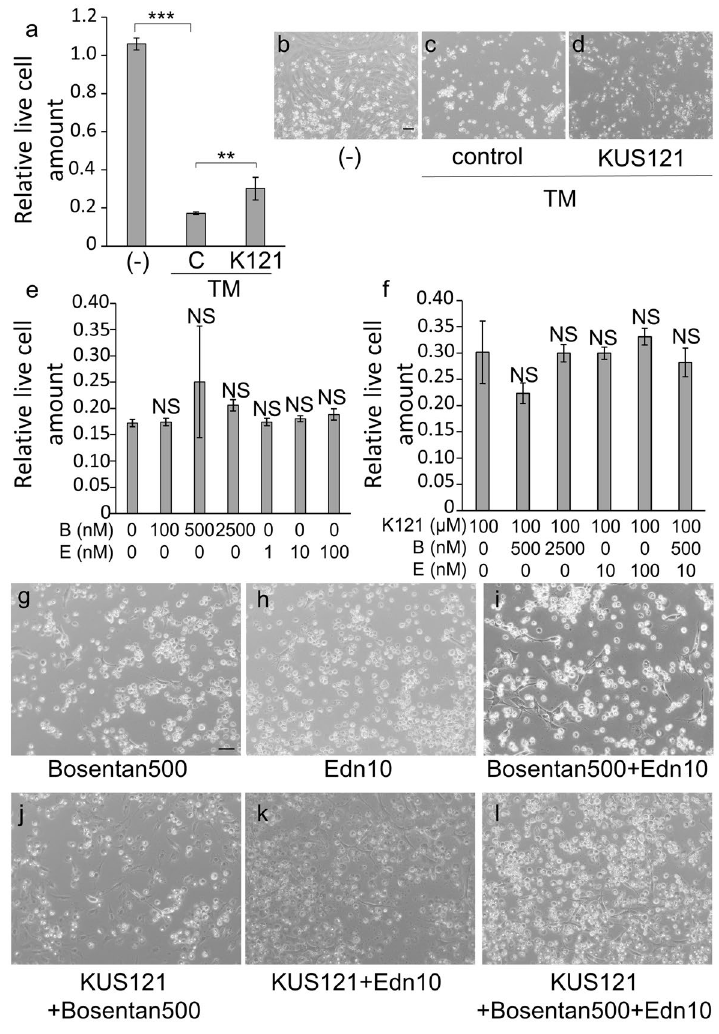
Figure 7. Cell viability of 661W cells under endoplasmic reticulum stress. Cells were analyzed following 40 h treatment with tunicamycin (TM, 0.2 µg/mL) and with or without KUS121 (100 µM). ( a ) Quantitative analysis of live cells ( n = 3, for all treatments). 661W cells were treated without TM and without KUS121 [labeled ‘‘(-)’’], with TM and without KUS121 (control, labeled ‘‘C’’), or with TM and KUS121 (labeled ‘‘K121’’). ** p < 0.01, *** p < 0.001, Tukey’s HSD. ( b – d ) Representative images of 661W cells cultured under each condition. ( e , f ) Quantitative analysis of live cells ( n = 3, for all treatments). 661W cells were treated with TM and with ( f ) or without KUS121 ( e ) with bosentan (0; 100; 500; 2500 nM) or endothelin-1 (0; 1; 10; 100 nM). NS no significant difference, vs. control (without bosentan nor endothelin-1) in ( e ), vs. KUS121 (without bosentan nor endothelin-1) in ( f ), Tukey’s HSD. K121: KUS121, B : bosentan, E : endothelin-1. ( g – l ) Representative images of 661W cells cultured under each condition. Bar: 50